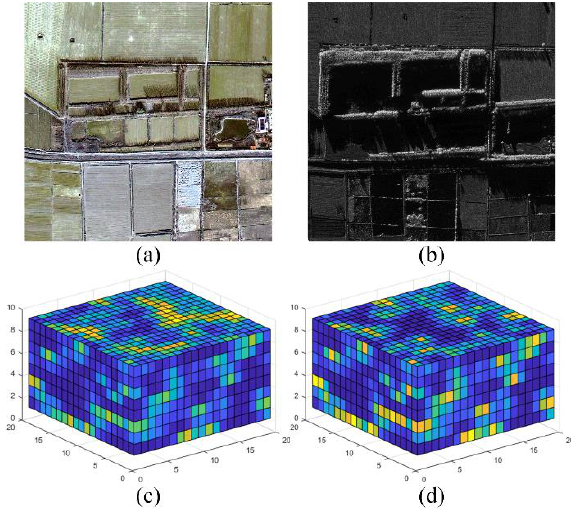
Figure 5. (a) optical image. (b) SAR image. (c) 3-D structural feature representation of optical image. (d) 3-D structural feature representation of SAR